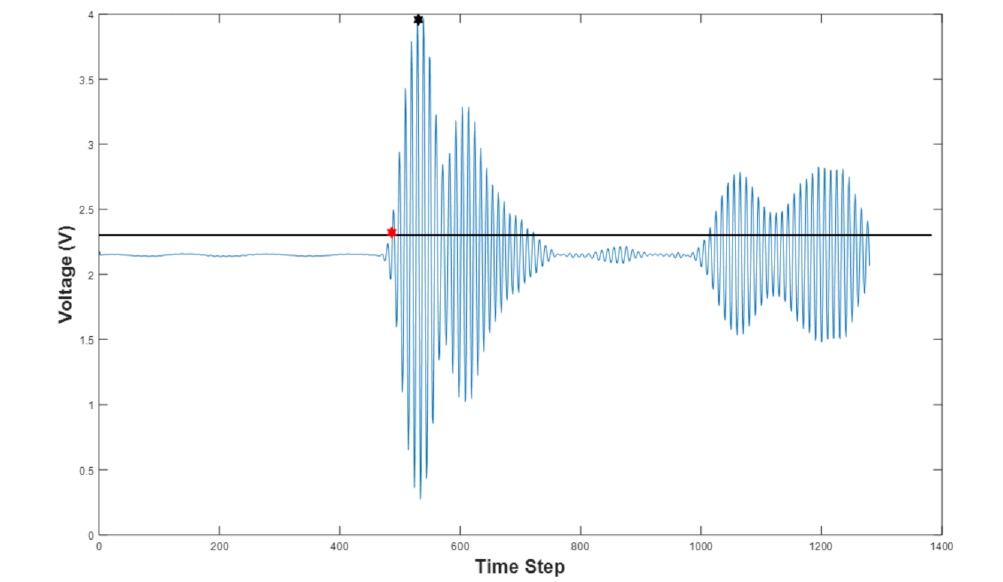
Figure 2. Recorded full-waveform signal from 1st transmitter-6th receiver